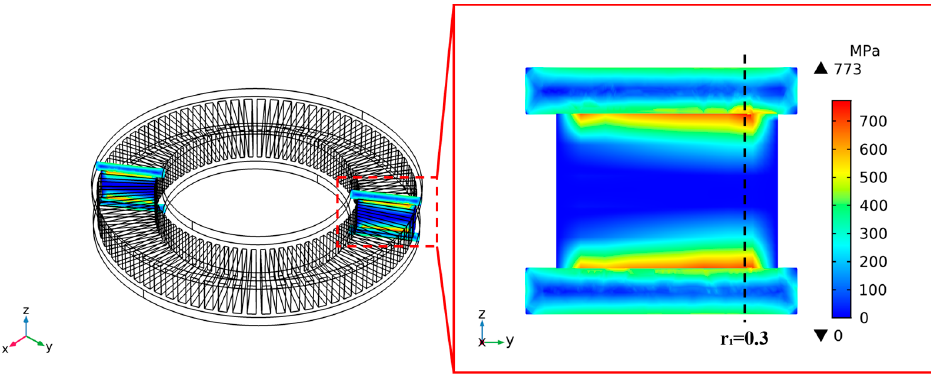
Figure 17. Stress cloud in the axial section of a ventilated brake disc.